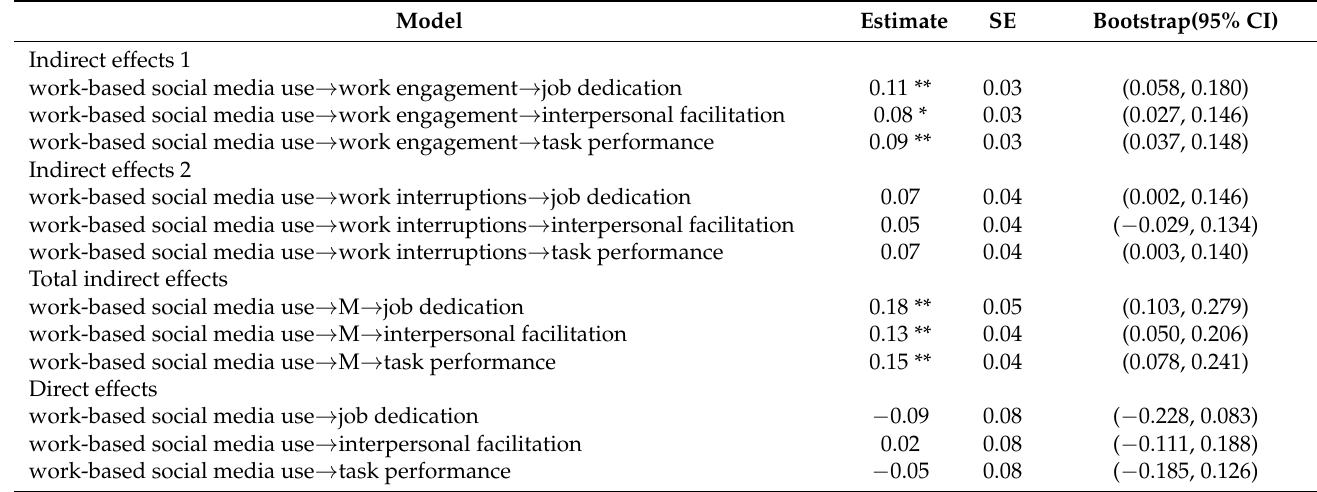
Table 4. Results of the multiple mediating effects